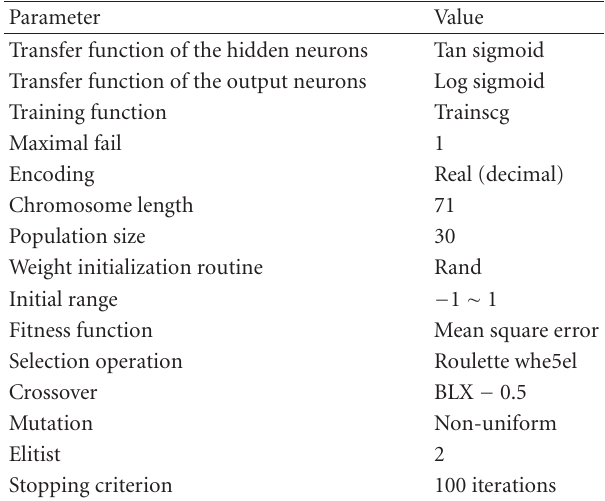
Table 1: Standard parameter set for